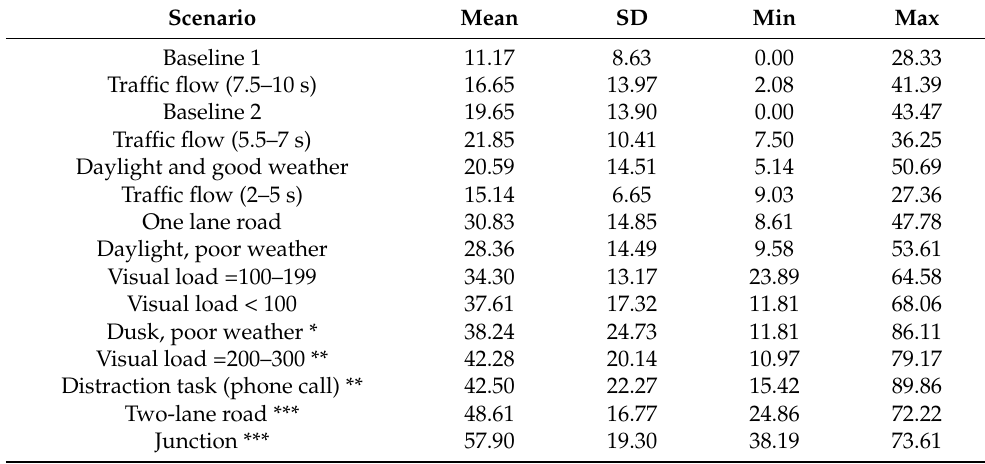
Table 3. SIM-TLX mean ratings by scenario (arranged from lowest to highest mean score).